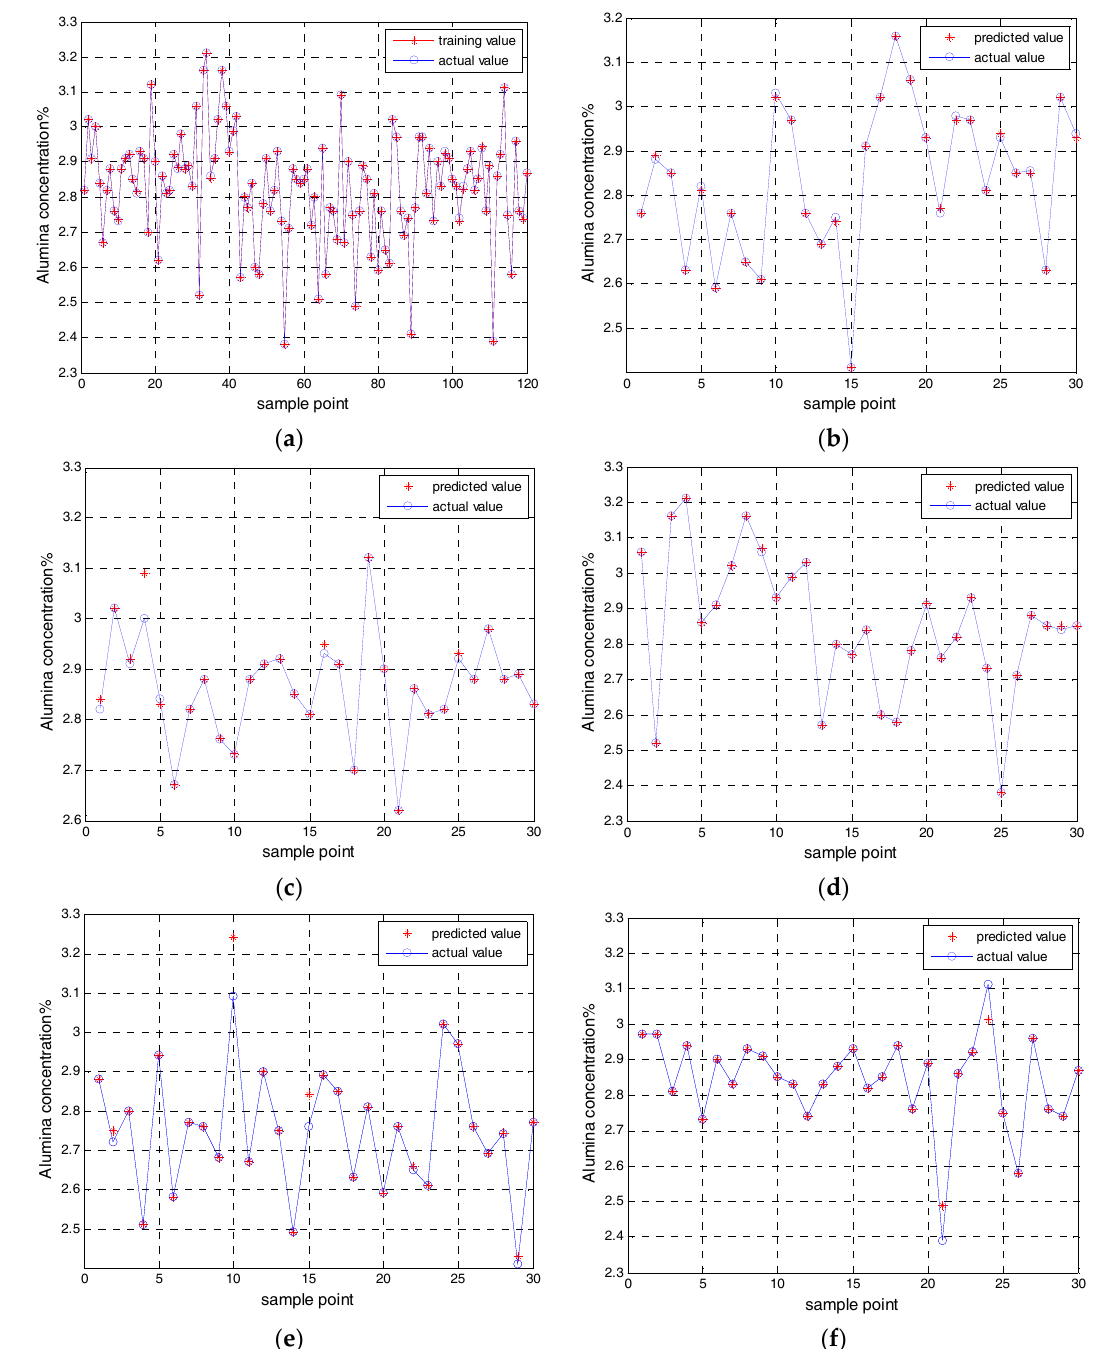
Figure 4. The training value and the predicted value of the KELM soft sensor model. ( a ) The training value of the first test subset; ( b ) The predicted value of the first test subset; ( c ) The predicted value of the second test subset; ( d ) The predicted value of the third test subset; ( e ) The predicted value of the fourth test subset; ( f ) The predicted value of the fifth test subset. Through the application of the cross validation and the KELM model, five root-mean-square error (RMSE) were obtained by five test subsets. The average of the five root-mean-square errors are used as a standard to measure the effect of the model. Five root-mean-square errors (RMSE) of the KELM model are shown in Table 1.